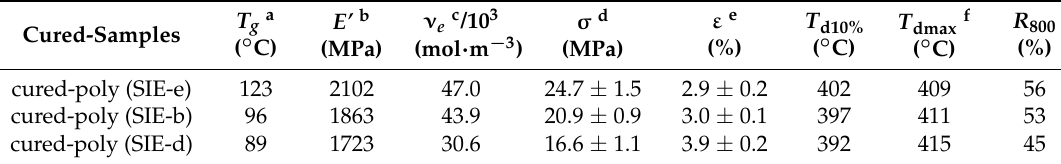
Table 2. DMA and TGA data of the cured